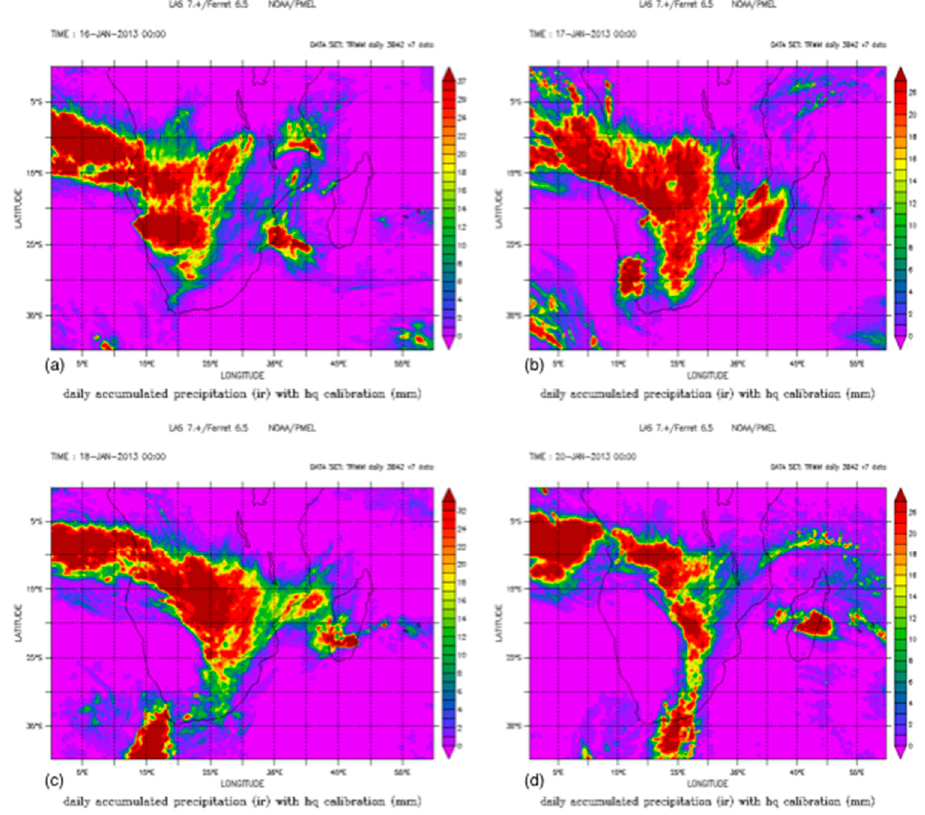
Figure 12. Tropical Rainfall Measuring Mission (TRMM) daily-accumulated precipitation (mm) (http: // apdrc.soest.hawaii.edu / las / v6 / constrain?var = 16121). Accumulated daily precipitation on 16 ( a ), 17 ( b ), 18 ( c ) and 20 ( d ) over southern Africa in January 2013. In all the days, maximum precipitation is observed from west through central-to-south of the mainland. Synoptic features controlling airflow and precipitation include convergence zones superimposed upon regional factors (e.g., topography, maritime air). Convective development over most of Africa extends much further south, and is partially caused by the ITCZ and other factors. The major oceanographic feature of the SWIO is the warm Agulhus Current that flows along the east and south coasts of South Africa and is the most intense western boundary current in the Southern Hemisphere [15]. Common weather phenomena include amongst others, the northeast and southeast monsoons and the southwesterly humid air from the Congo [68]. Analyses of atmospheric patterns described above, and circulations associated with the extreme rains observed over land suggest that they were associated, or linked with a number of systems, particularly TTTs and strong westerly moisture fluxes from the tropical South East Atlantic Ocean. Substantial positive (negative) temperature anomalies in some places could also have contributed to the regional instabilities during January. The low-level moisture flux, particularly from the